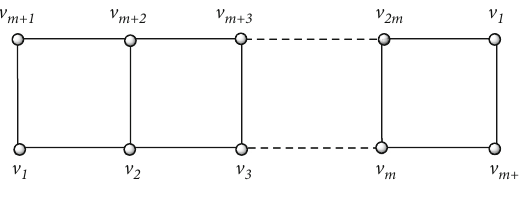
Figure 1: Möbius ladder graph ML